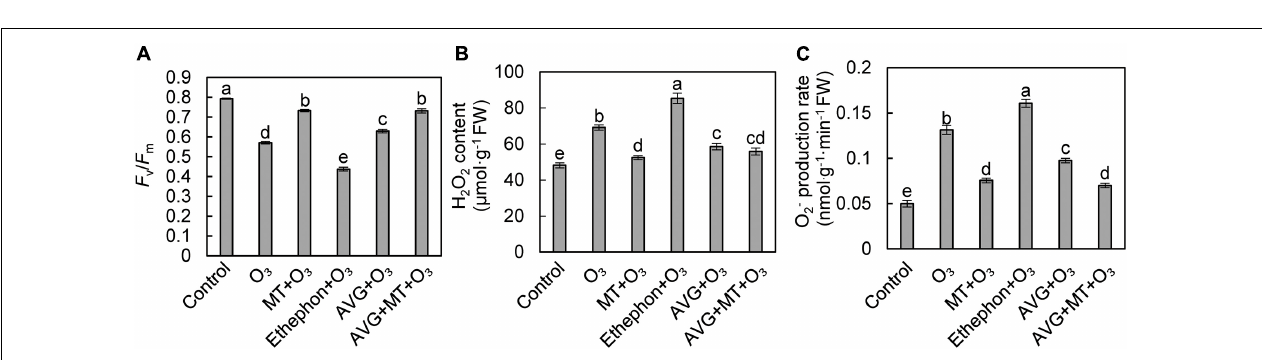
FIGURE 3 | Effects of O 3 , MT + O 3 , Ethephon + O 3 , AVG + O 3 , and AVG + MT + O 3 treatments on F v /F m (A) and ROS (B,C) of “Cabernet Sauvignon” grape leaves. Values represent the mean of three replicates ± SD. Different lowercase letters above the bars indicate significant difference ( P <